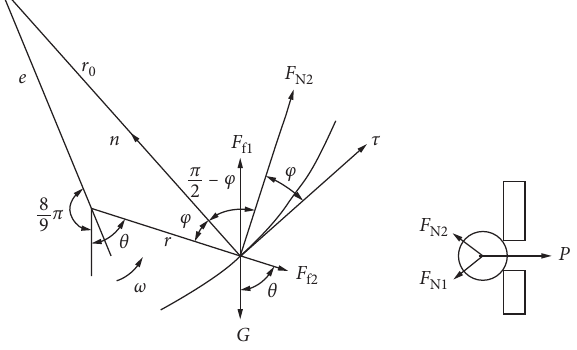
Figure 6: Force analysis of cotton seeds.